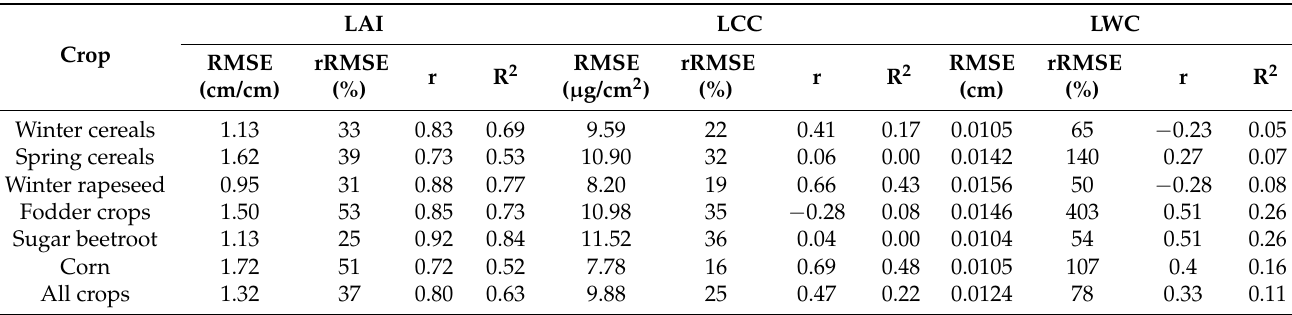
Table 5. Validation of LAI, LCC, and LWC estimations against in situ data: crop level results (statistics aggregated by crop types across all campaigns).